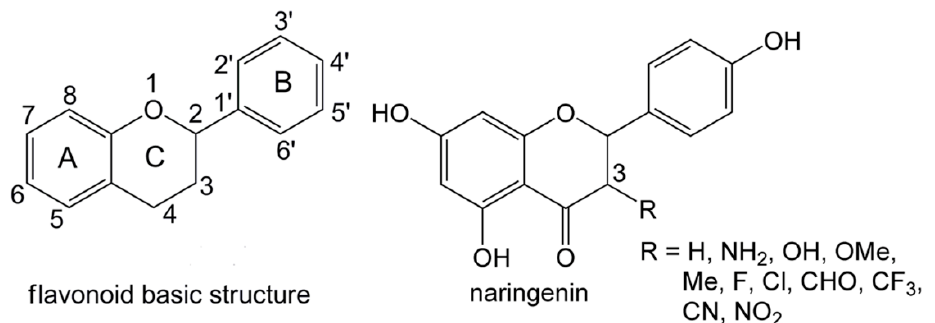
Figure 1. The flavonoid basic structure and the chemical structure of naringenin.